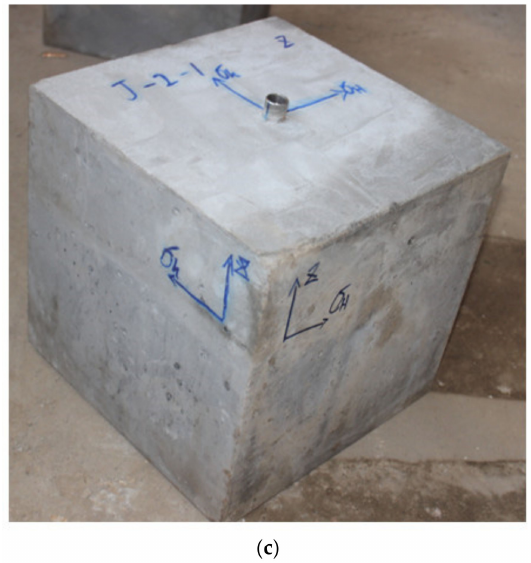
Figure 1. Details of sample preparation: ( a ) wellbore design; ( b ) sample schematic diagram; and ( c ) a typical prepared sample.